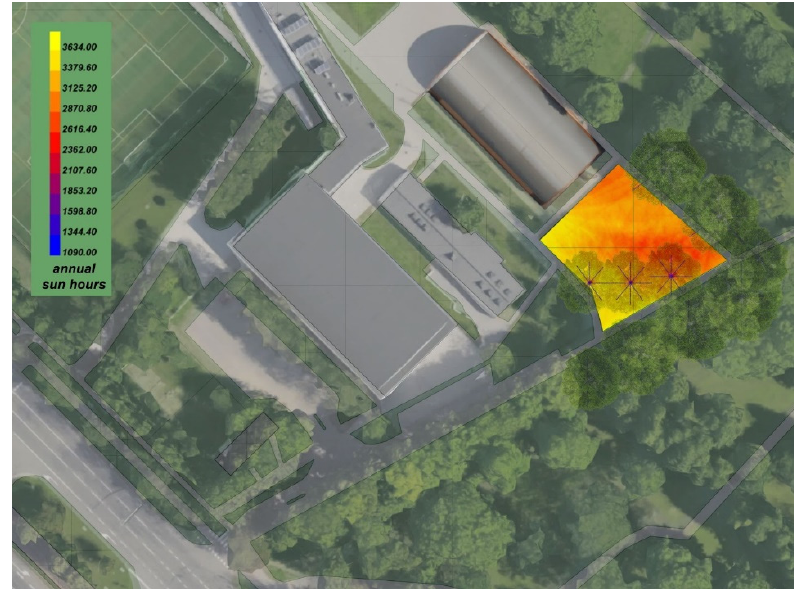
Figure 2. Location of sample scenario.